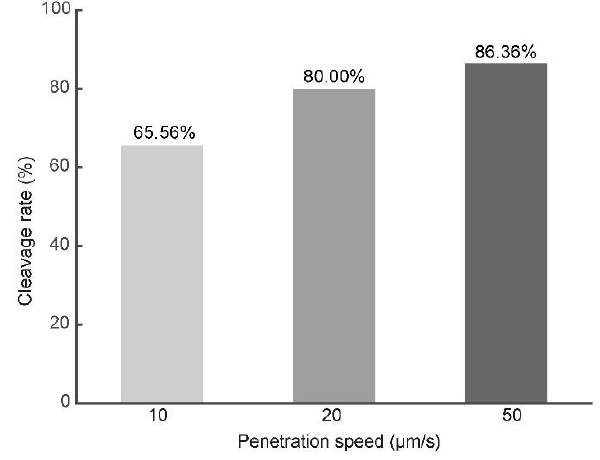
Figure 6. The cleavage rates of the embryos at different penetration speeds.